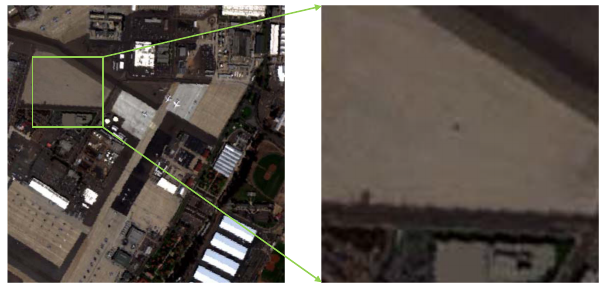
Figure 3. Hyperspectral Data Sets. Left is the original San Diego airport image, and right is the selected area for forming the simulated